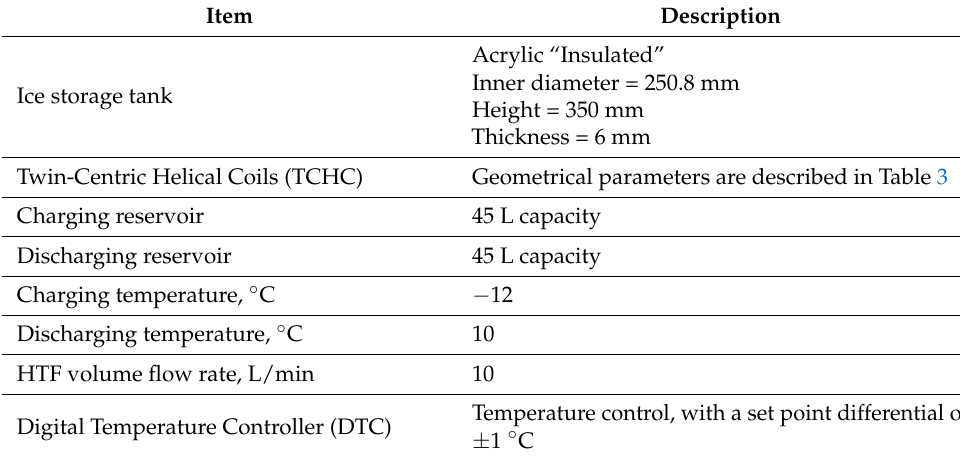
Table 2. Experimental setup specifications.